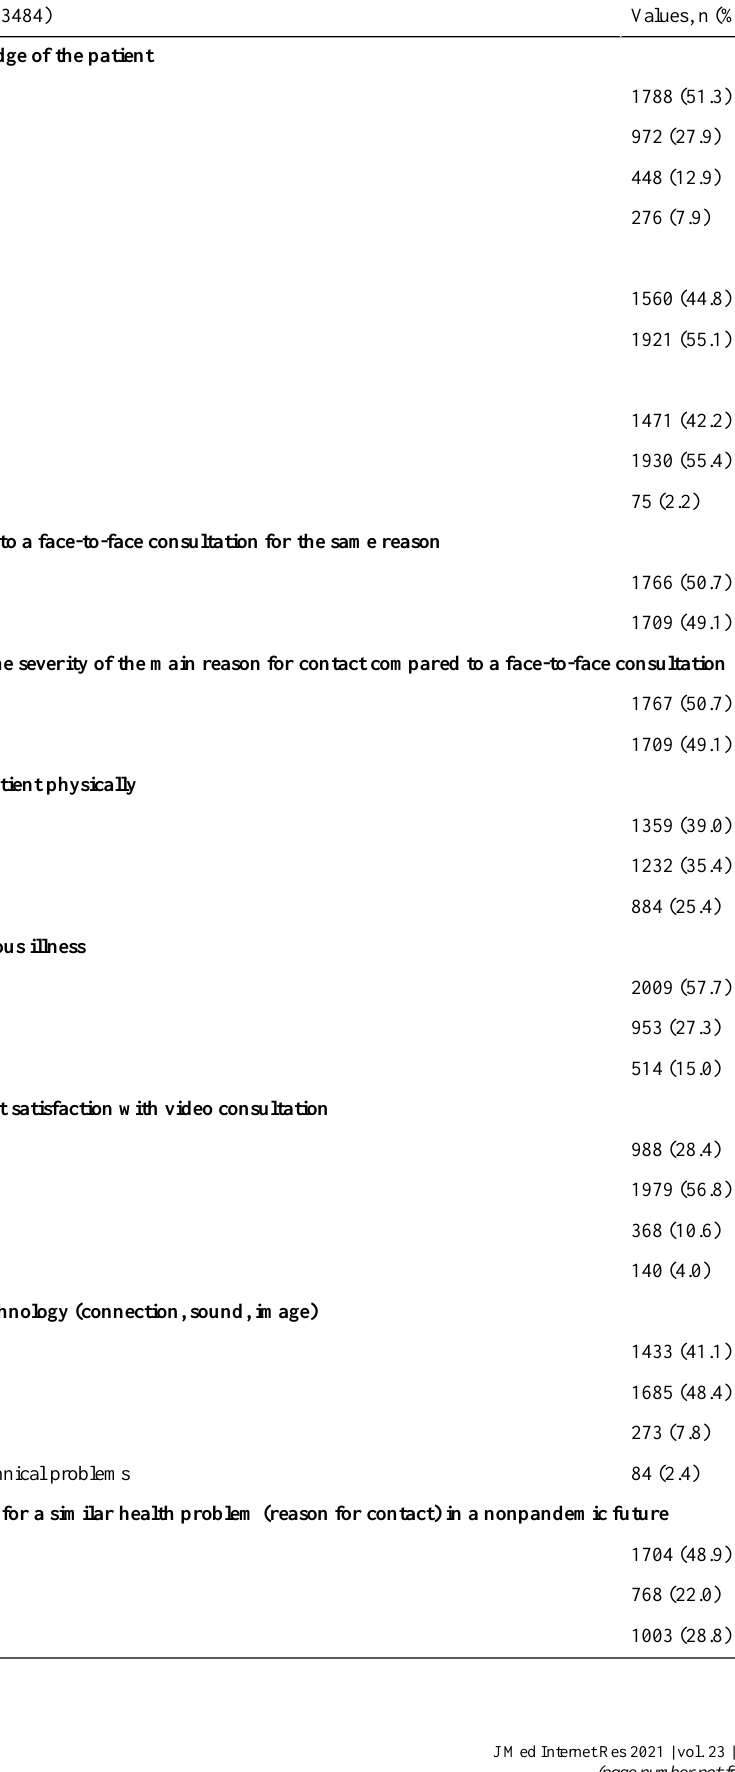
Table 2. Characteristics of the 3484 recorded video consultations. Missing answers (ranging from 0-9 general practitioners per question) are not